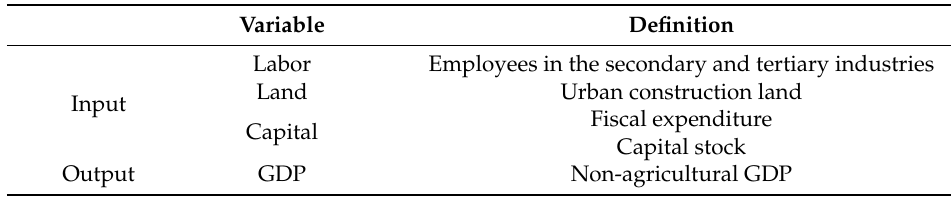
Table 1. Urban space utilization efficiency index